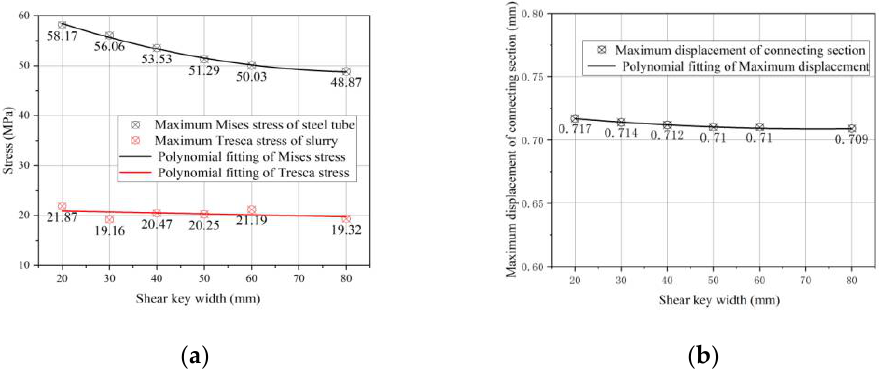
Figure 11. Variation of maximum stresses and displacement of grouted joints with shear keys in different widths. ( a ) Stresses in steel and grout. ( b ) Vertical displacement.